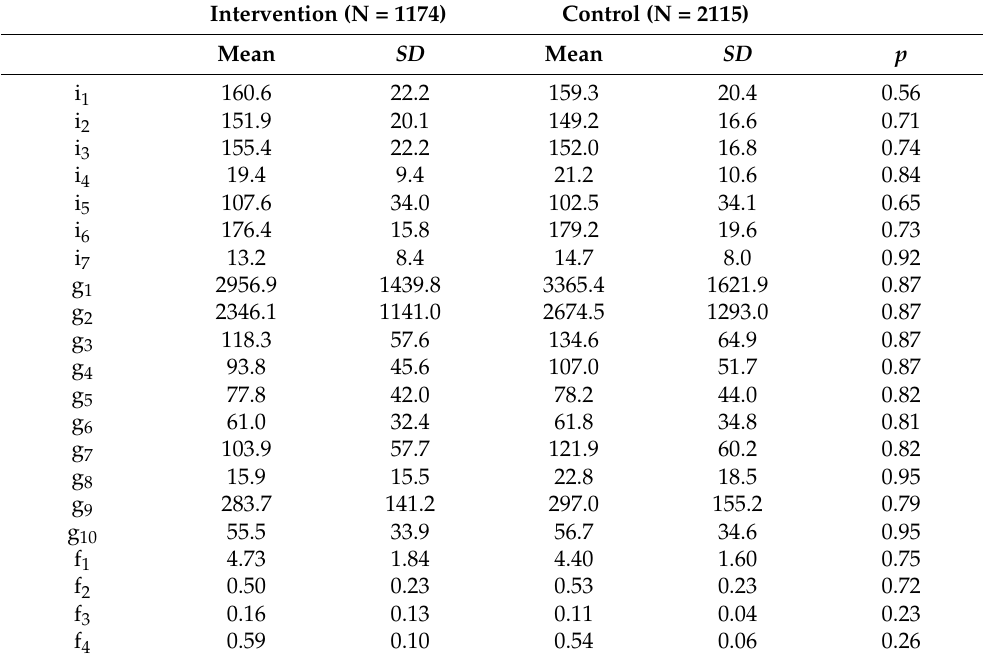
Table 5. Mean values and standard deviation (SD) of features extracted from BME lesions in MR images of psoriatic arthritis patients. Differences between the intervention and control group, in terms of changes in feature values from the baseline to the 3-month scan, were investigated using a linear mixed effect model (random effects: patient number and lesion number (nested effects), fixed effects: baseline or 3 months scan and control or intervention group). p values are